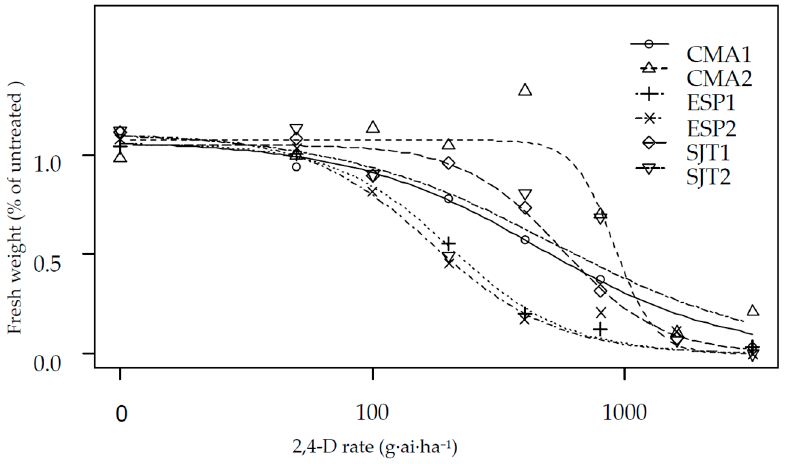
Figure 1. Weight response of six biotypes of Amaranthus hybridus to 2,4 ‐ D.